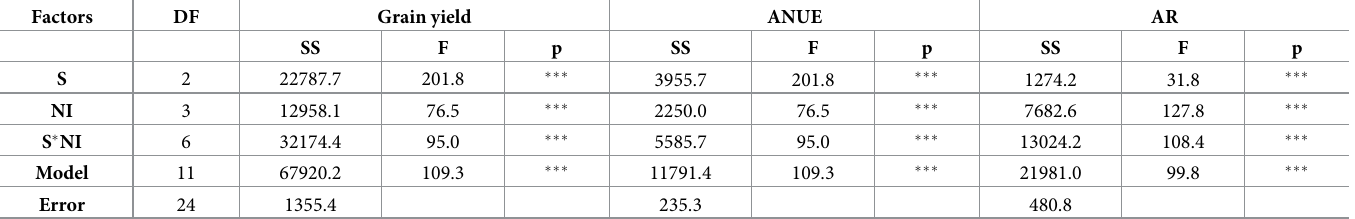
Table 3. Two-way ANOVA ( P < 0.05) of soil types (S) and nitrification inhibitor (NI) on grain yield, agronomic nitrogen use efficiency (ANUE) and apparent nitro- gen recovery (AR) of maize. Factors